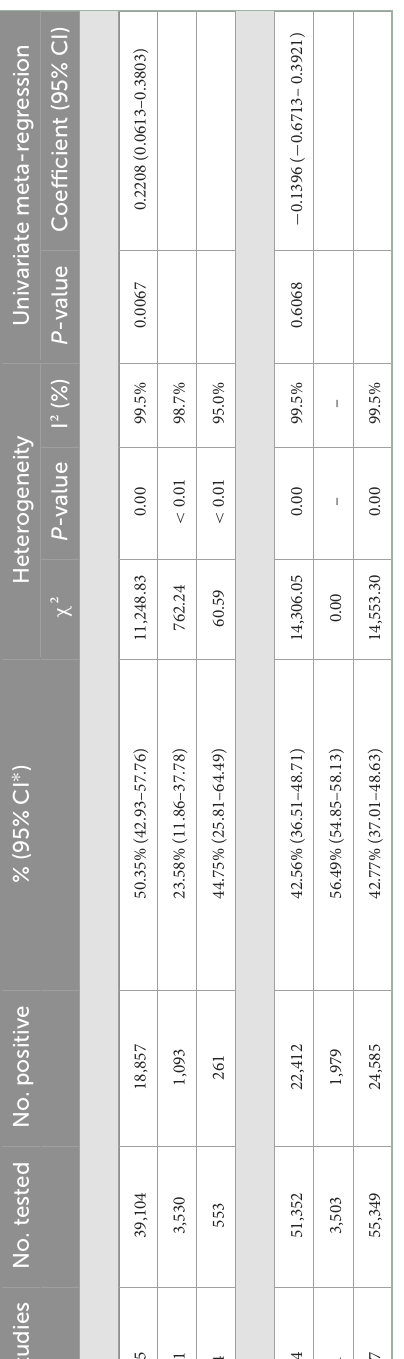
Table 4, Supplementary Table 2) followed by North